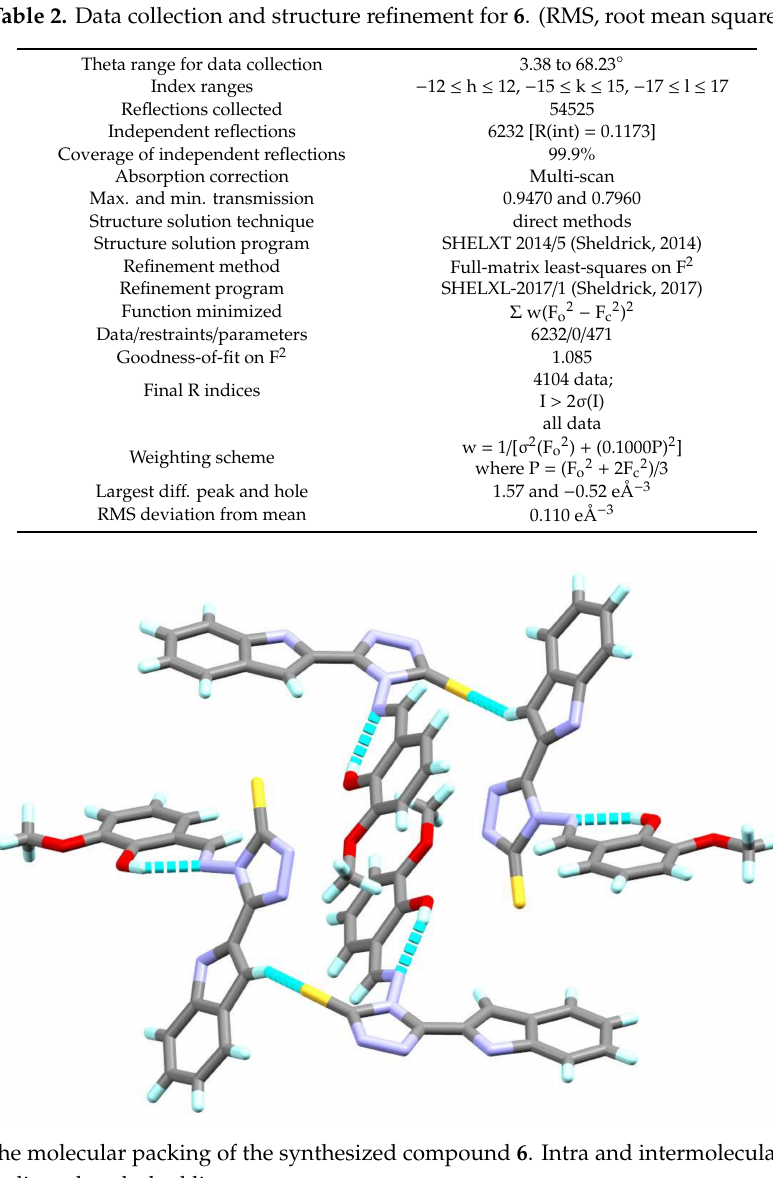
Figure 4. The molecular packing of the synthesized compound 6 . Intra and intermolecular hydrogen bonds are indicated as dashed